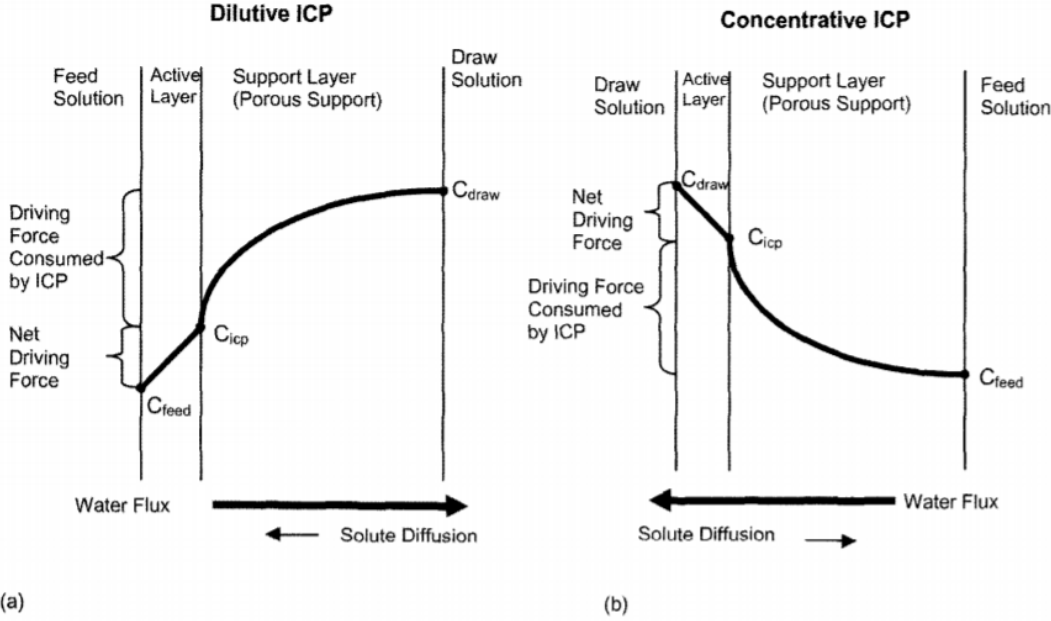
Figure 7. Schematic representation of ( a ) dilutive internal concentration polarization (ICP) and ( b ) concentrative ICP (reprinted with permission from [83], Copyright 2006, Elsevier).